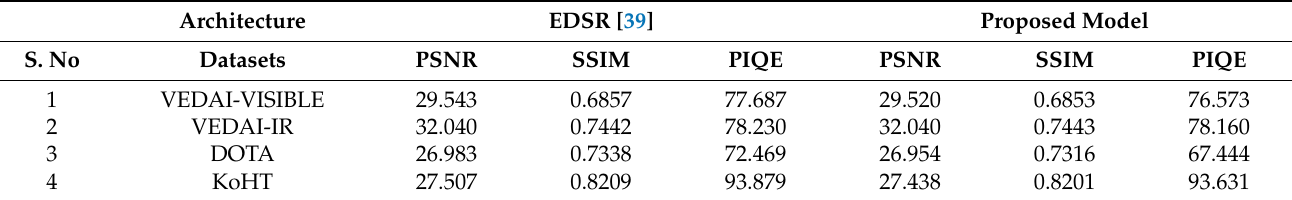
Table 3. Comparison of SR architectures based on up-sampled (4 × ) aerial datasets.